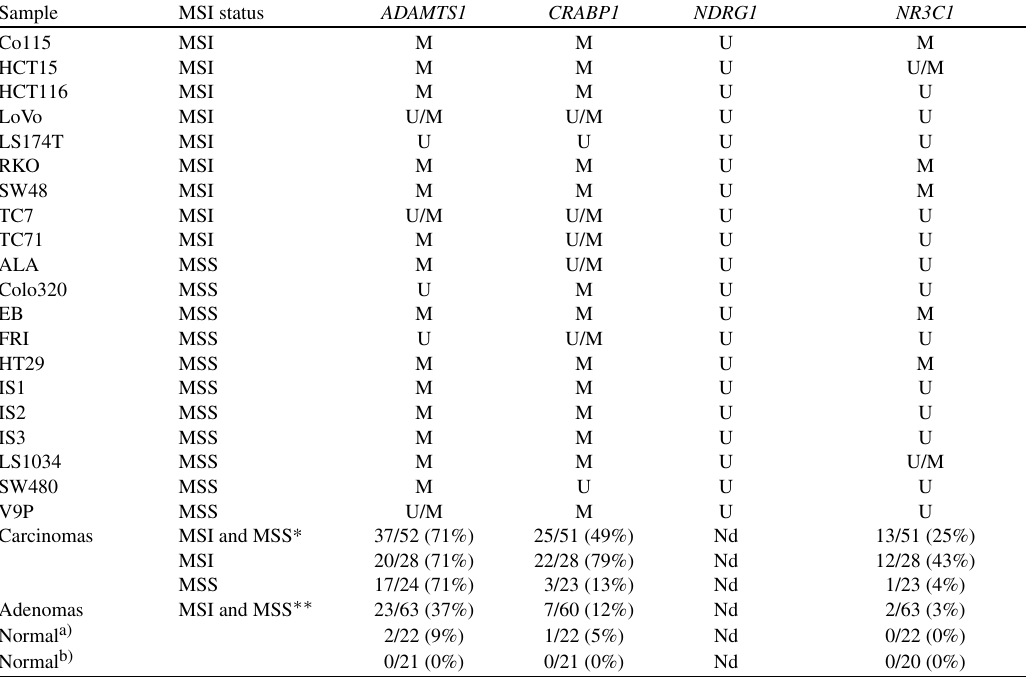
Promoter hypermethylation of candidate genes in colon cancer cell lines, colorectal carcinomas, adenomas, and normal mucosa Sample